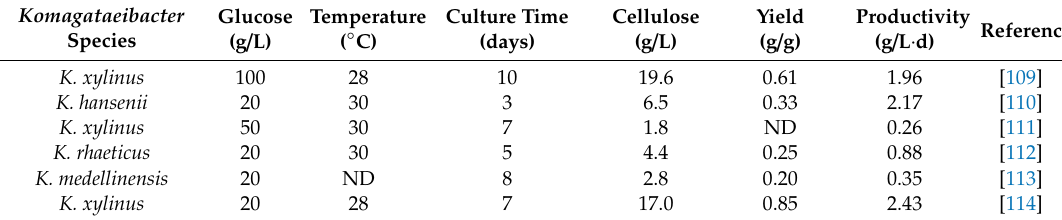
Table 3. Komagataeibacter species cultures to produce cellulose, using glucose as main carbon source. The conversion yield is expressed as gram of cellulose per gram of glucose